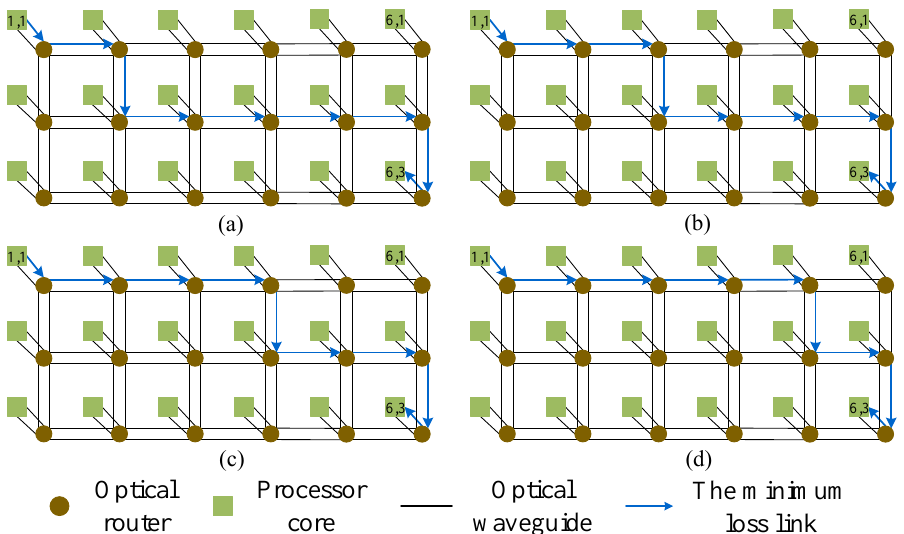
Figure 5. Example: Four routing paths with the minimum power loss when optical signals travel from processor core (1, 1) to processor core (6, 3). ( a ) Link : link ( Injection , East ) , link ( West , South ) ,